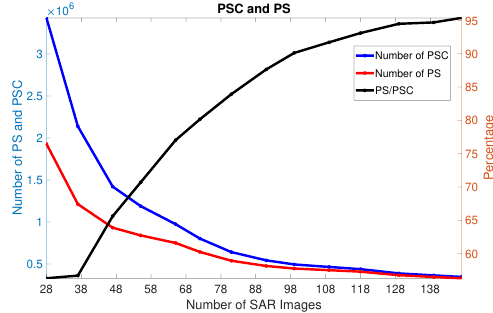
Figure 4. Number of PSC, PS and their ratio (Approach A).